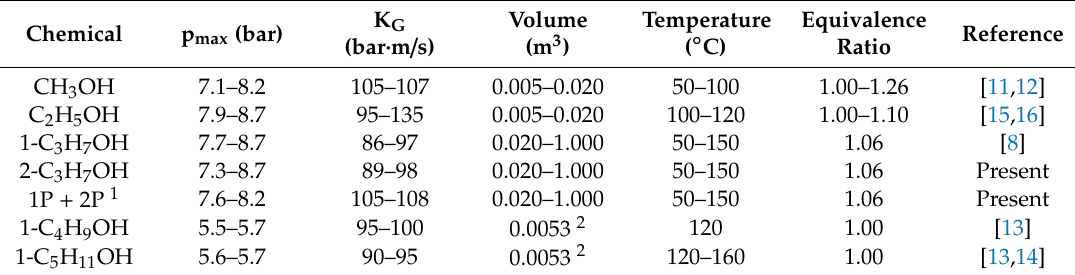
Table 6. Presented and published p max and K G